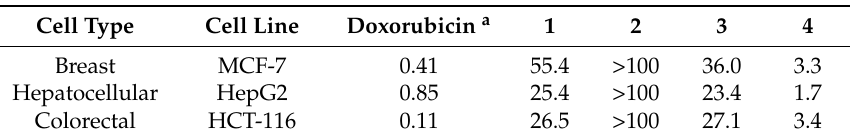
Table 2. Growth-inhibitory activity of compounds 1 – 4 ( in vitro IC 50 ( µ M) growth-inhibitory values) against three human solid tumor cell lines.